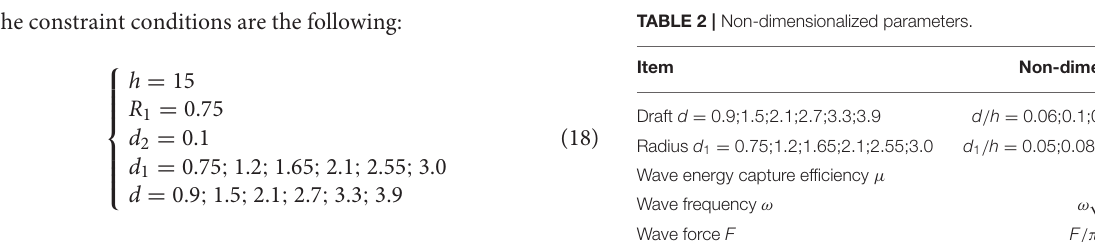
FIGURE 4 | Wave energy capture efficiency under different oscillating water column (OWC) structural parameters. (A) d / h (D) d / h 0.18; (E) d / h 0.22; (F) d / h 0.26. = = =